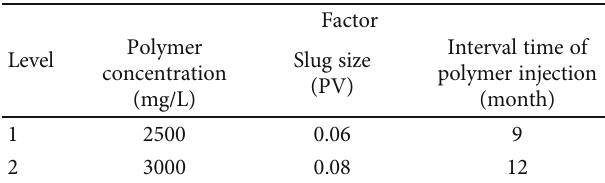
Table 2: Orthogonal design factors and their level values in pro fi le control fl